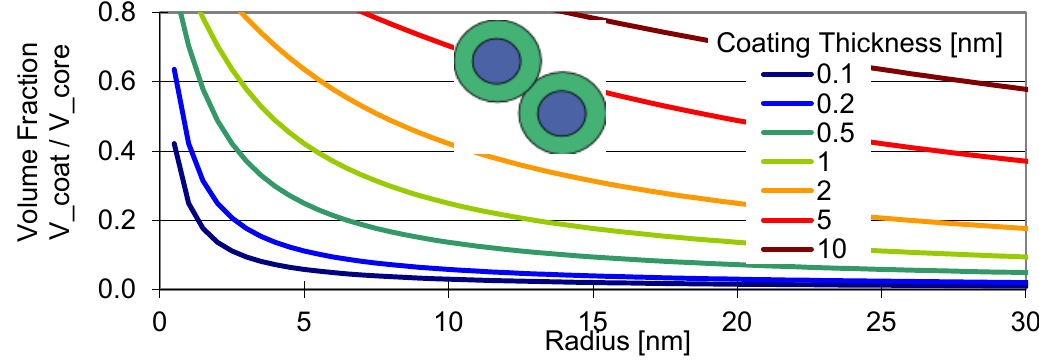
Figure 4. Ratio of coating layer volume versus core volume as a function of nano-particle radius and coating layer